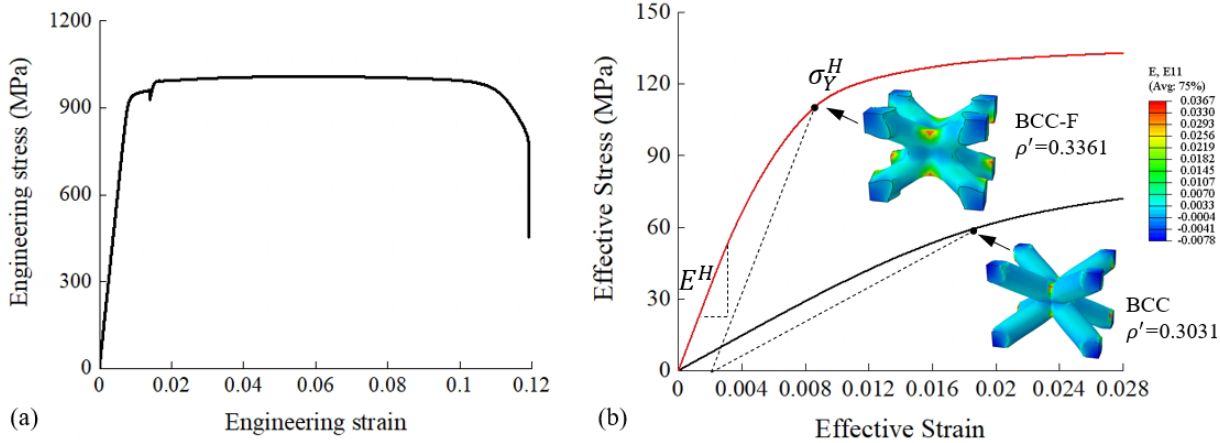
Figure 3. The stress–strain curves of ( a ) parent material, i.e., SLM fabricated Ti6Al4V, for lattice metamaterials, and ( b ) examples of a BCC-F and a BCC lattice RVEs, where 𝐸 (cid:3009) and 𝜎 (cid:3026)(cid:3009) are the effective Young’s modulus and the effective yield stress, respectively. The stress–strain curves of the parent material and the example RVEs were obtained experimentally and numerically, respectively.